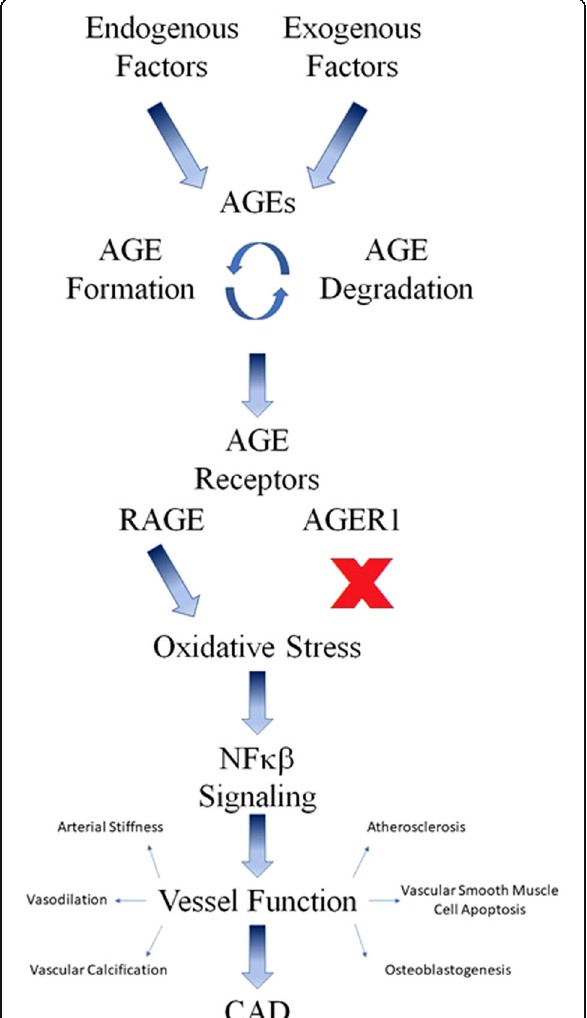
Fig. 2 AGE signaling cascade implicated in the development of CAD. Both endogenous and exogenously derived AGEs are involved in a cycle of formation and degradation. AGEs are recognized by two different classes of receptors which either activate or suppress the generation of reactive oxidative species. Oxidative stress leads to activation of NF κβ with multiple effects on vessel function which contribute to the development of